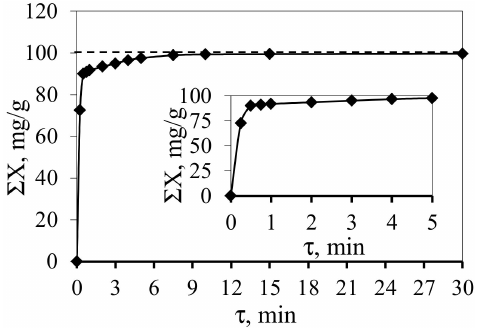
Figure 4. Integral kinetic Curve of Co 2+ ion adsorption by α -C 2 SH when the initial concentration of Co 2+ was equal to 1 g/dm 3 .